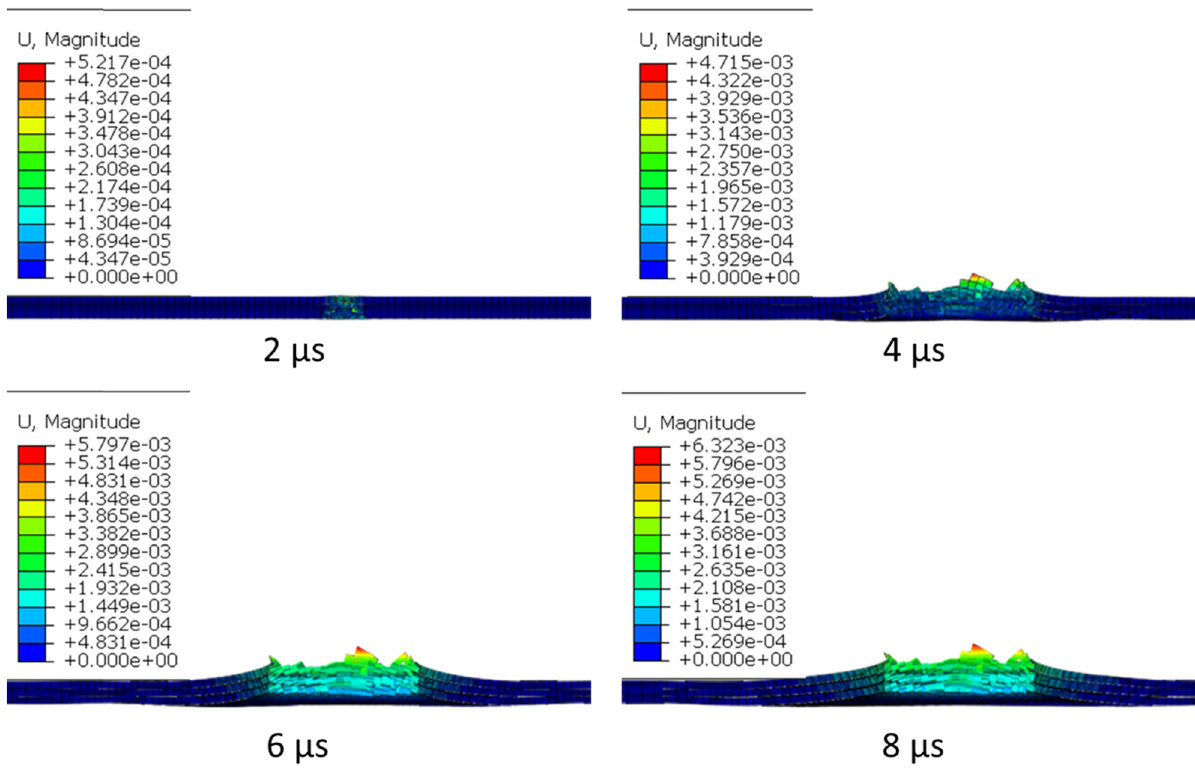
Figure 19: Displacement for model 7 against ogive projectile.